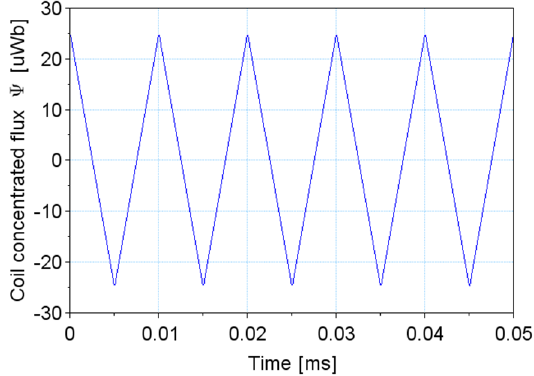
Energies 2021 , 14 , x FOR PEER REVIEW 15 of 21 Figure 16. Coil concentrated flux Ψ waveform for the case with a rectangular voltage source.